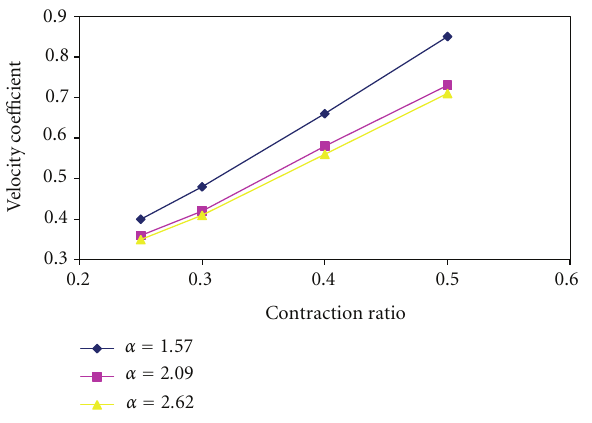
Figure 5: E ff ects of throat contraction ratio on velocity coe ffi cient of Venturi injector.